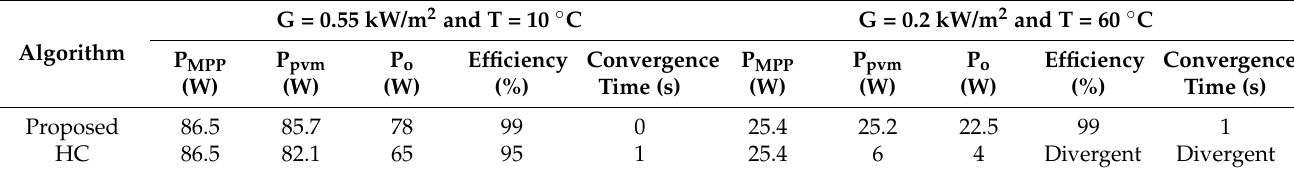
Table 5. Comparison of two algorithms’ MPPT efficiency under